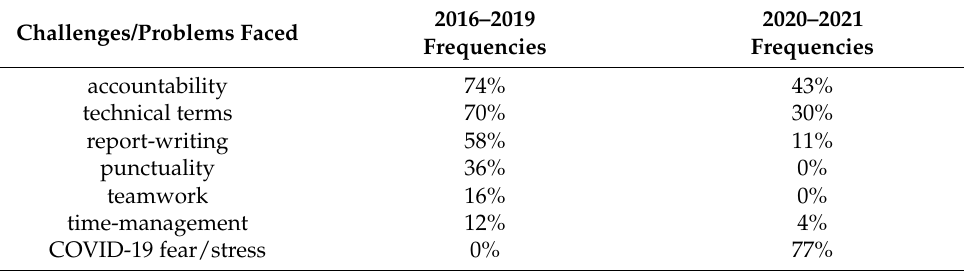
Table 4. Challenges faced during